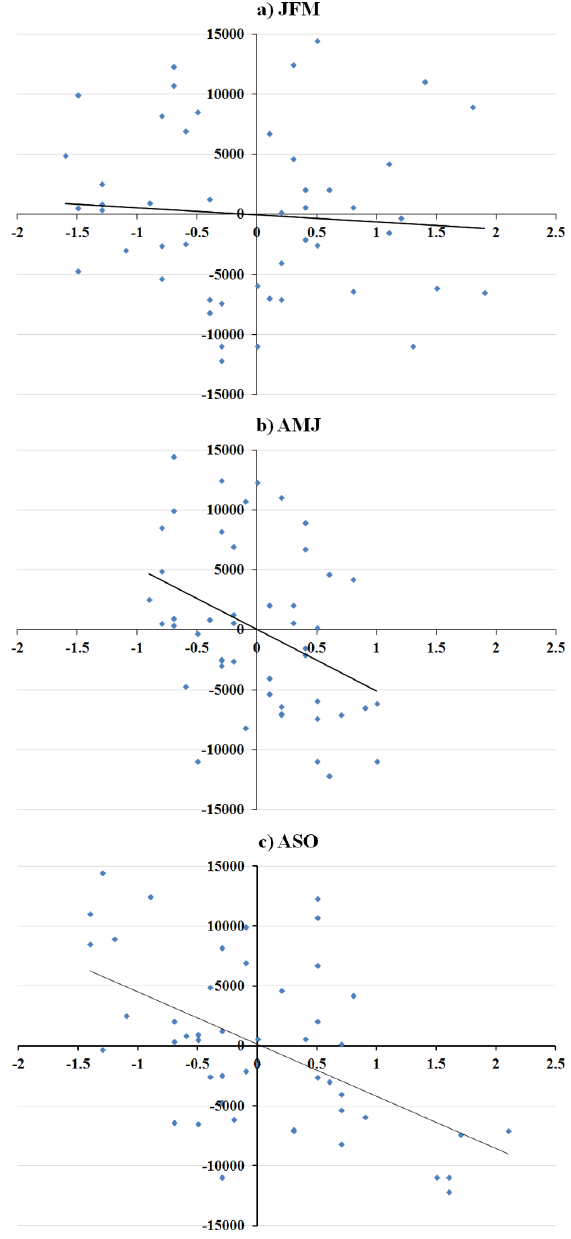
Fig. 7. The scatter plots for the discharge anomalies at Eldiem sta- tion versus Niño 3.4 during (a) JFM, (b) AMJ, and (c) ASO, for the period